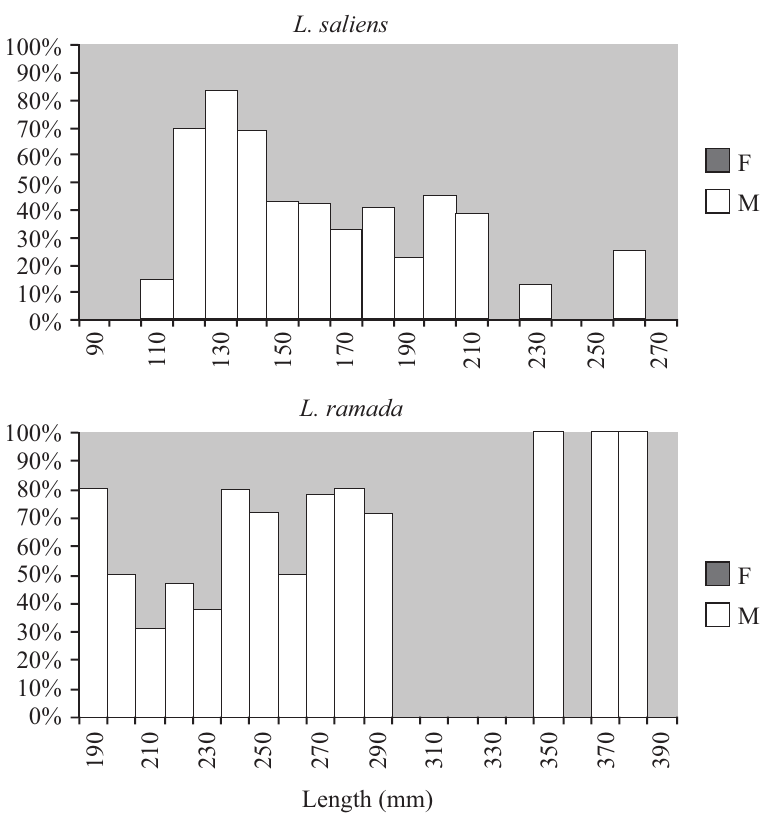
Fig. 2. Sex ratio (%) of mature males (M) and females (F) of Liza saliens and Liza ramada by size class (SL, mm)